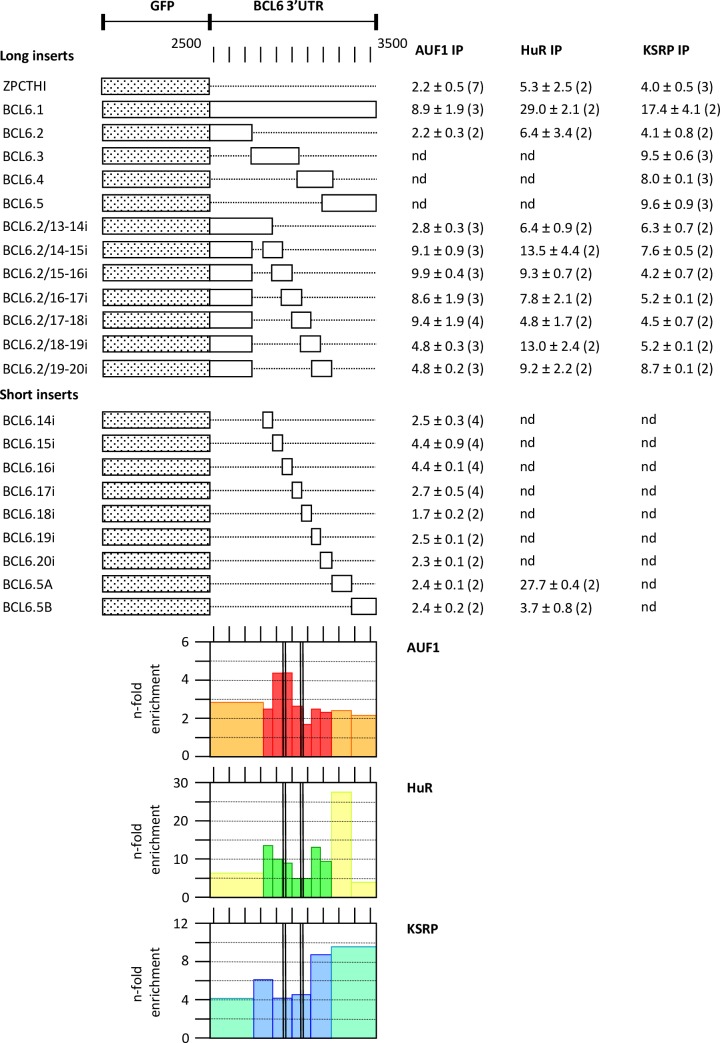
Binding-sites for AUF1 p37, HuR and KSRP in the human BCL6 3’UTR.Various pZPCTHI constructs with long or short inserts of the 3’UTR of human BCL6 mRNA were transiently transfected with Lipofectamine 2000 into HEK 293T cells along with vectors to express tagged ARE-binding proteins. 21 h post transfection, cells were lysed and protein-bound RNA co-immunoprecipitated and recovered as shown in Fig 1 and described in Materials and Methods. RNA was isolated from input, microbead-adsorbed pellet and non-bound supernatant fractions, and EGFP and endogenous GAPDH mRNA quantified by RT-PCR. For each recombinant ARE-binding protein, the % adsorbed versus totally recovered RNA was calculated, and the relative enrichment of EGFP mRNA versus GAPDH mRNA expressed as “n-fold enrichment” ± standard deviation (number independent experiments). The graphs below show a graphical representation of the results. Vertical black bars indicate the location of instability elements.